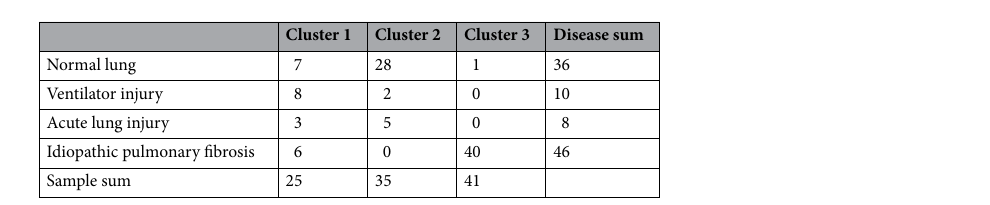
Figure 5. Idiopathic Lung Fibrosis characterization using GTEx. ( a ) A heat map representing the centered normalized expression of matrisome genes in clusters LUNG-Fib.1 or LUNG-Fib.2 between lung samples. The x-axis of the lung samples indicates disease, batch, tobacco usage, sex, and age status of each. Age and being in batch Sivakumar—2 significantly correlate with IPF samples (logistic regression; p = 0.012; p = 0.029 respectively). ( b ) A violin-sina plot of the normalized score of gene expression cluster LUNG-Fib.1 and LUNG- Fib.2 comparing IPF, acute lung injury, ventilator injury, and normal lung samples from Sivakumar et al . The color of each data point indicates the batch.